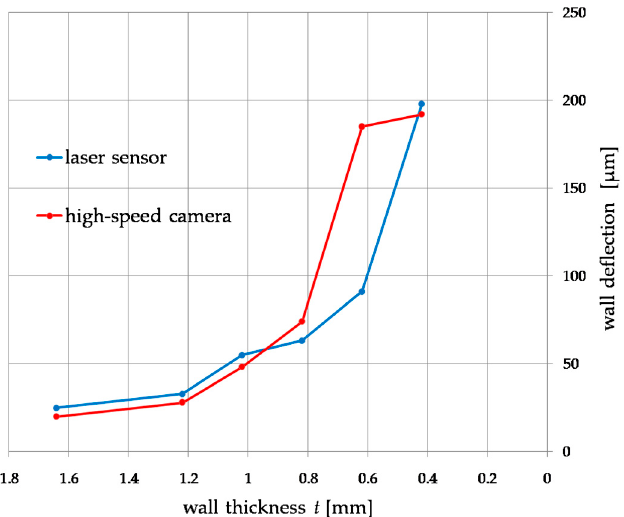
Figure 7. Comparison of the results of the measurement of deflection during thin-wall milling measured with a laser displacement sensor and a high-speed camera.